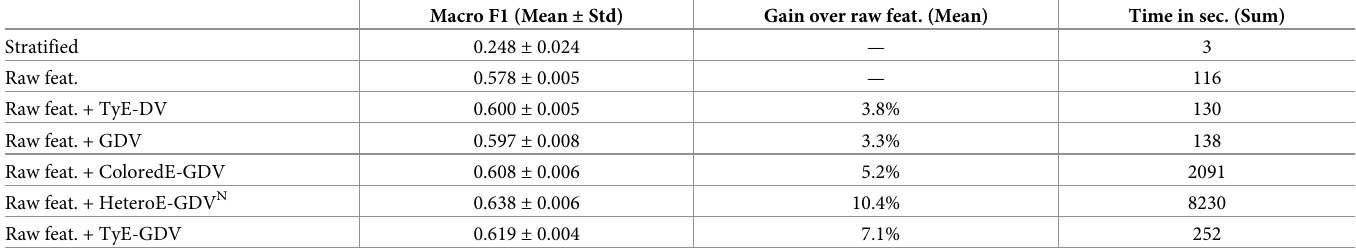
Table 3. Result table of node classification, reported in the average macro-F1 score ( ± standard deviation), the average percentage gain over the raw feature set, and the total running time of 500